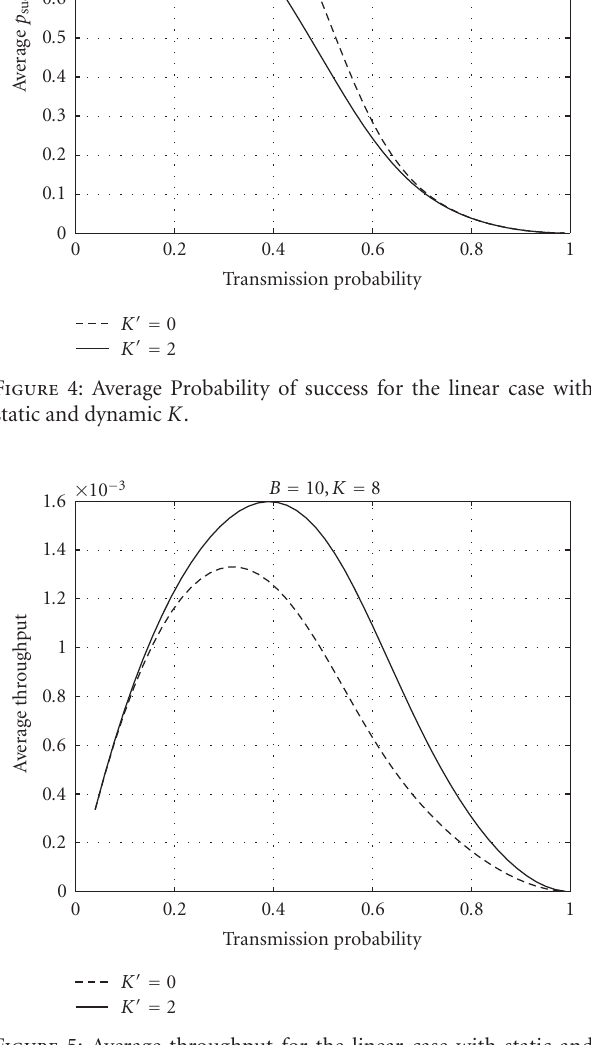
Figure 3: Stability region for the linear case with static and dynamic K .